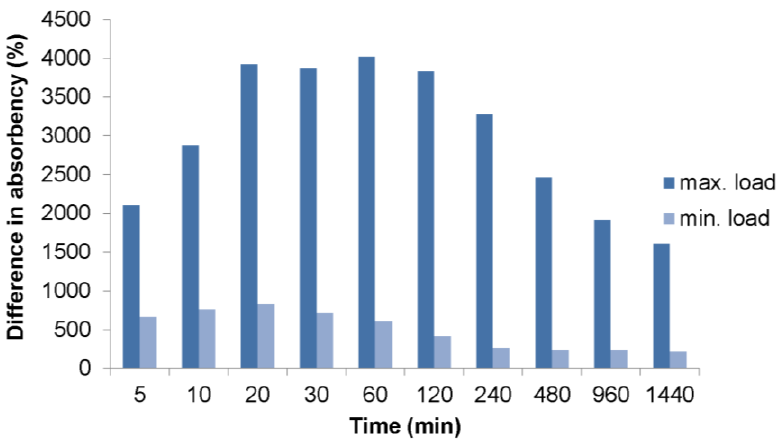
Figure 7. Percentage difference in water absorption.